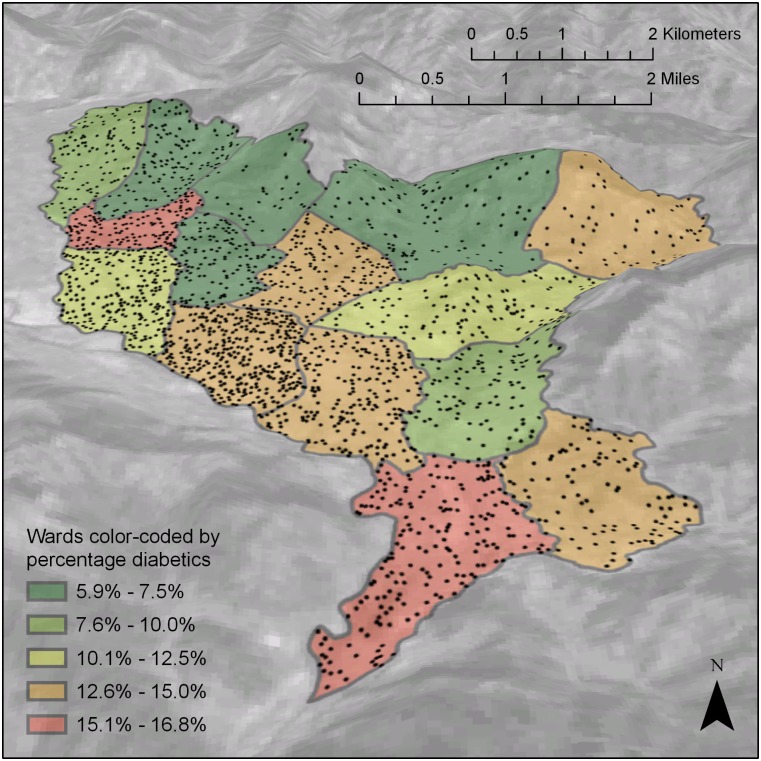
Map showing diabetes prevalence by project area.Wards in the project area are shown as individual polygons each containing a number of randomly placed dots equal to the number of participants from that ward. Map created using Esri ArcGIS Pro (Esri, Redlands, California, USA). Elevation exaggerated by a factor of 2.5. Data sources: Elevation and satellite image data available from the U.S. Geological Survey. Ward outlines from the Survey Department, National Geographic Information Infrastructure Project (Kathmandu, Nepal).